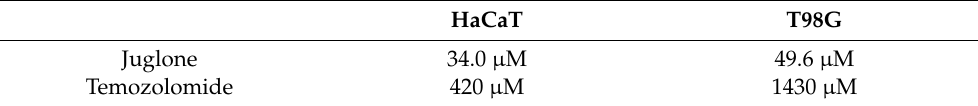
Table 1. IC 50 values of juglone and TMZ and for T98G and HaCaT cells at 24 h treatment.